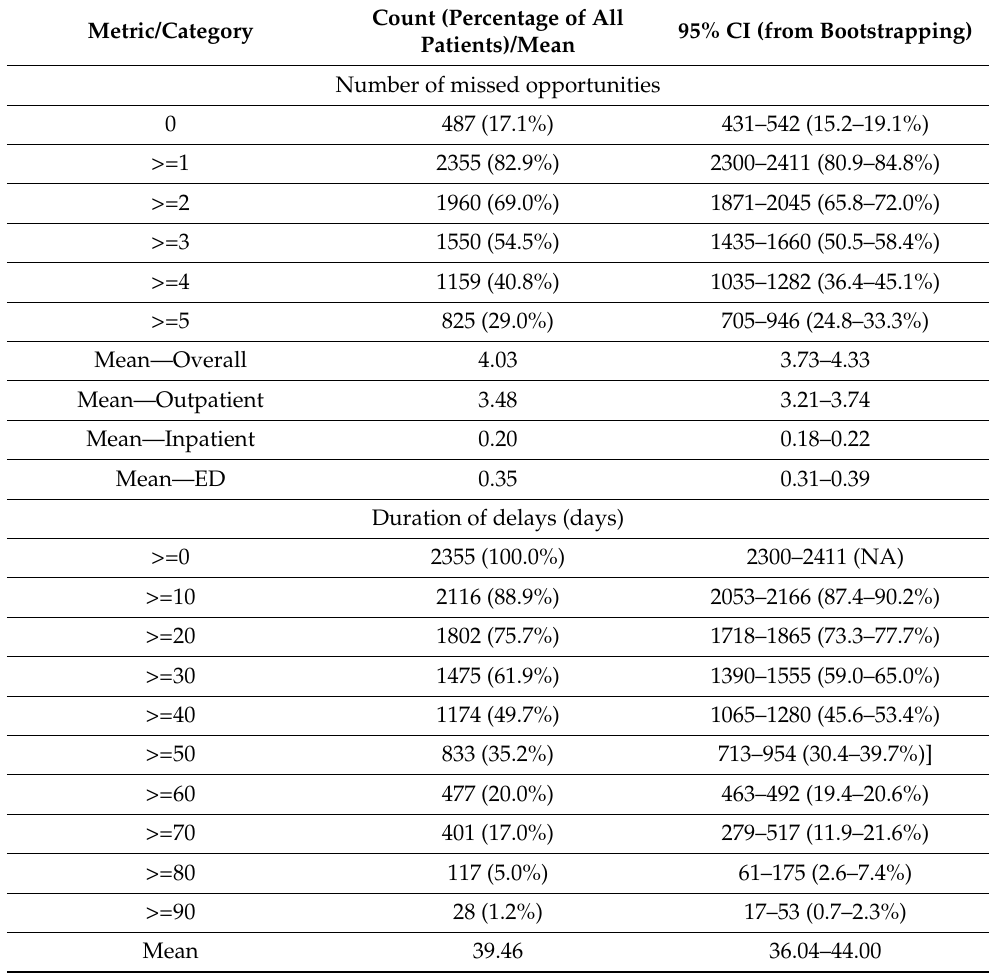
Table 2. Number of delays per patient (out of all patients).